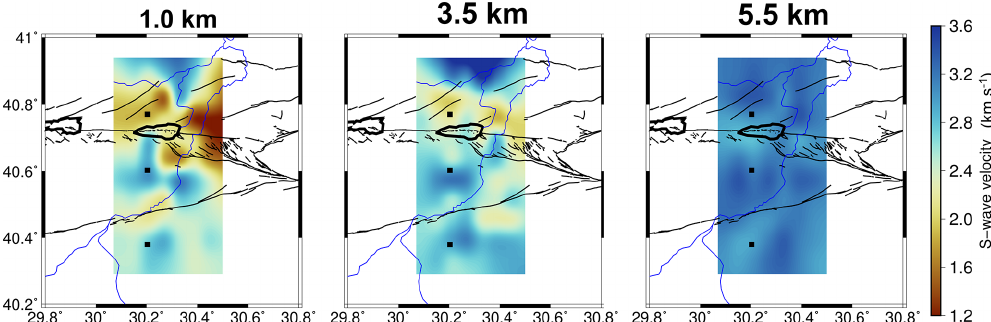
Figure 6. Isotropic S-wave velocity maps at 1.5, 3.5 and 5.5km of depth. Black lines show the mapped faults. The blue line represents the Sakarya River flowing towards the north. The black squares represent the locations of the nodes shown in Fig.